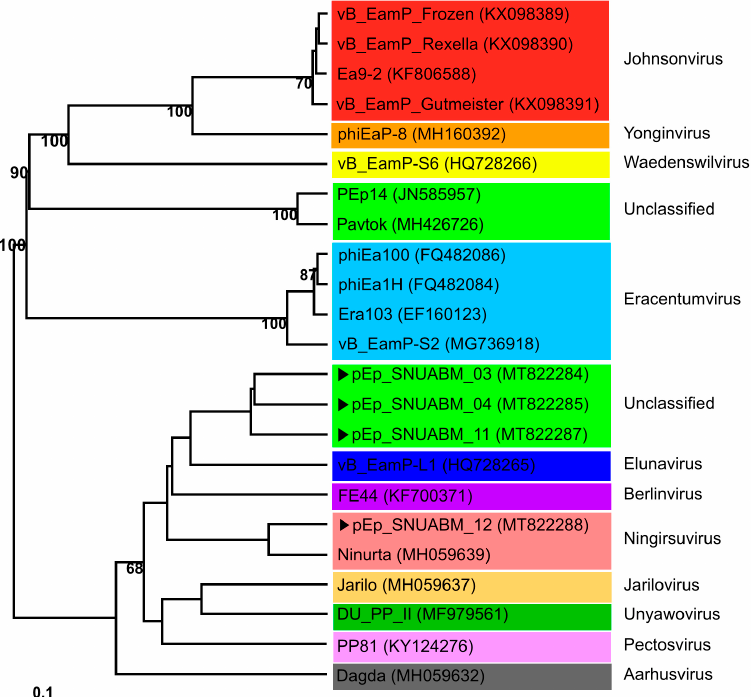
Figure 5. Whole-genome phylogenetic analysis of newly isolated Erwinia phages. The four phages isolated in this study are indicated with arrows ( ▶ ). The different genera ( Johnsonvirus , red box; Yonginvirus , orange box, Waedenswilvirus , yellow box; unclassified, light green; Eracentumvirus , sky- blue box; Elunavirus , deep blue box; Berlinvirus , purple box; Ningsuvirus , pink box; Jarilovirus , light orange box; Unyawovirus , green box; Pectosvirus , purple box and Aarhusvirus , gray box) are indicated using colors.